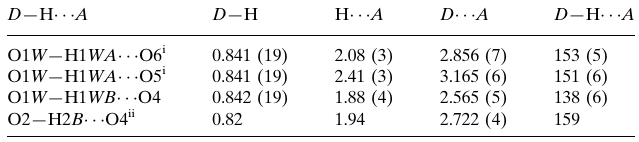
Hydrogen-bond geometry (A˚ , (cid:2)